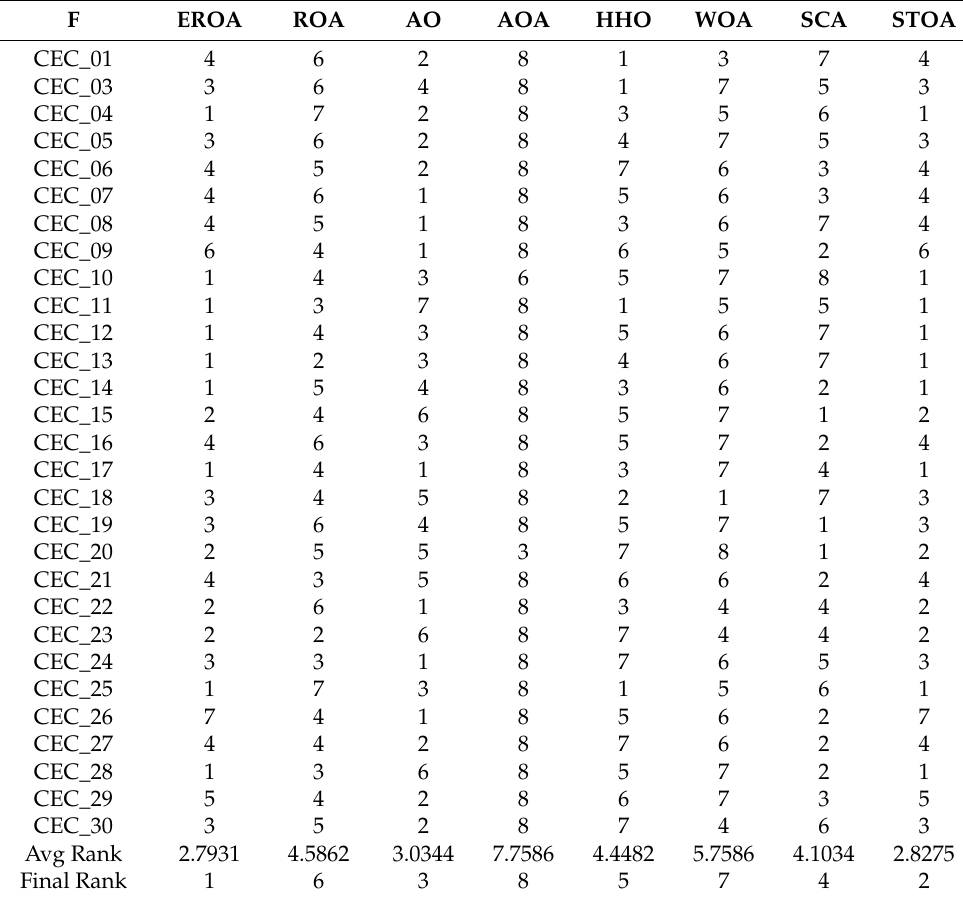
Table 8. Friedman rank test results on CEC2017 test